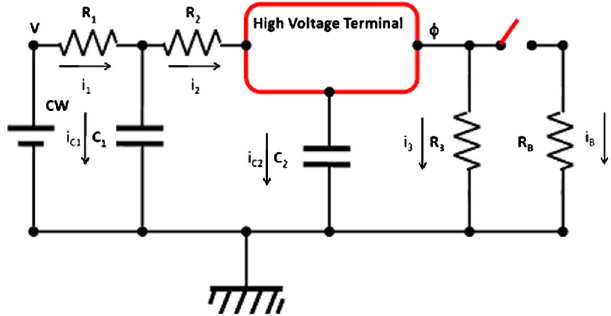
FIG. 9. Equivalent circuit of the HVT used to estimate voltage stability. R 1 and R 2 are the resistances of feeder line. R 3 is the resistance of the ceramic chamber. R B is the resistance seen by the beam current. C 1 is a capacitance inserted to stabilize the voltage. C 2 is the stray capacitance of the